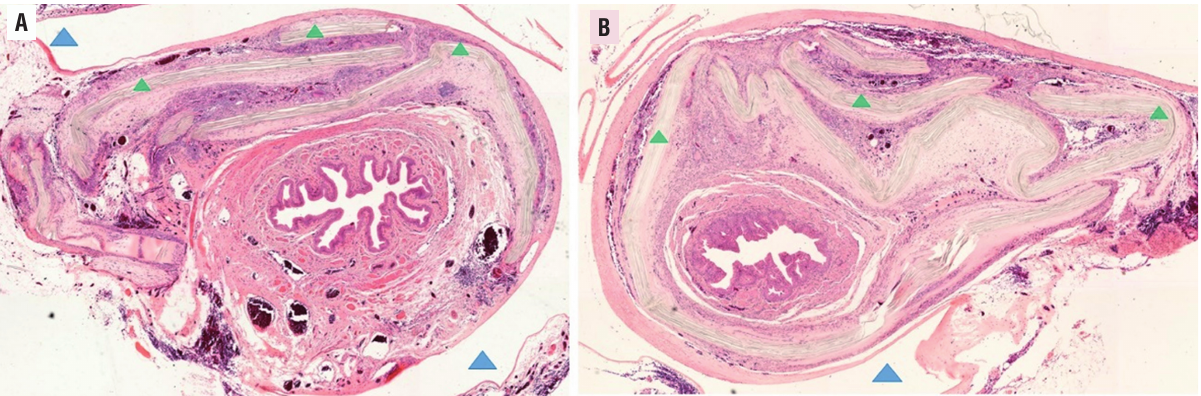
Figure 3 - Rats urethra photomicrograph cross section showing bacterial cellulose plus silicon implant after 4 months (A) and after 8 months (B). ( ∆ ) Area where the silicon implant had occupied; ( ∆ ) bacterial cellulose implants. Staining with hematoxylin and eosin (10X). Note: Silicone implants did not resist the histological processing, for that reason the area appears as an